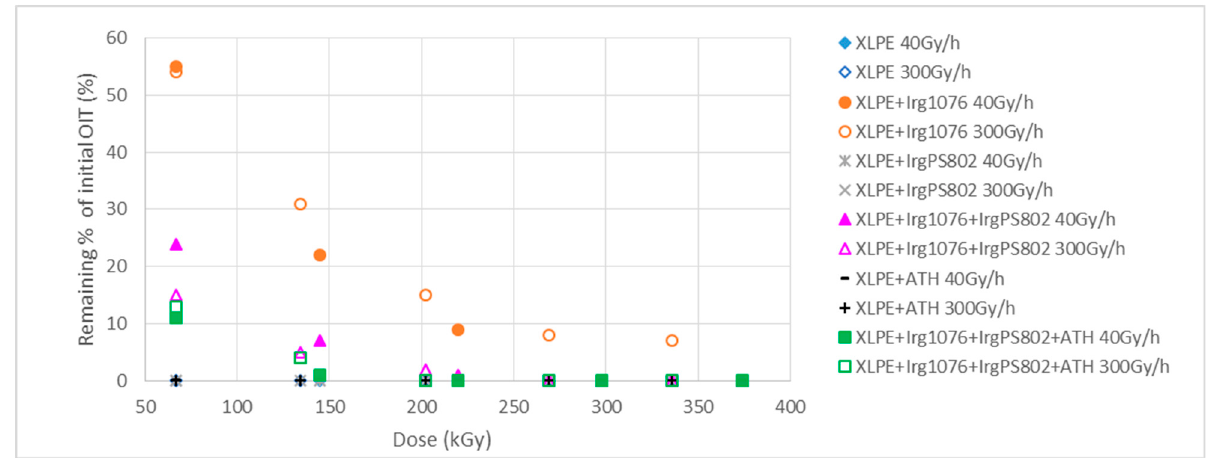
Figure 17. Remaining percentages of initial oxidative induction time (OIT) for the different samples (full markers: samples irradiated at 40 Gy/h, empty markers: samples irradiated at 300 Gy/h).